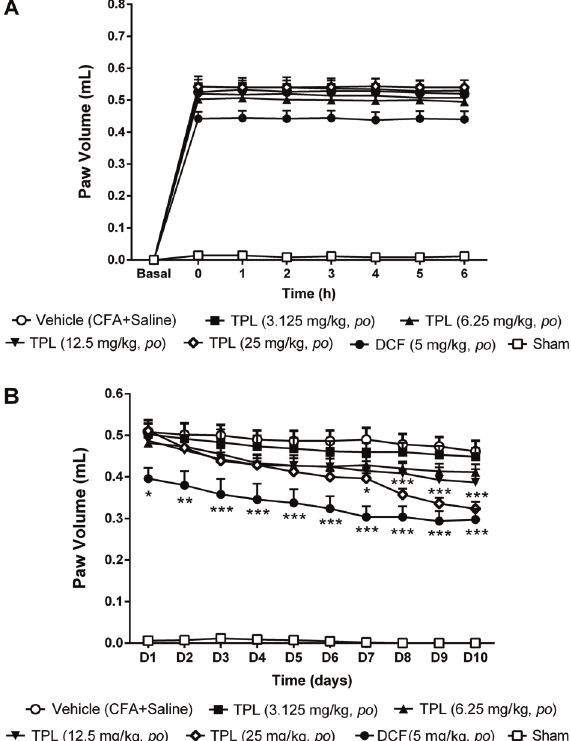
Figure 7 . Effect of acute ( A ) and chronic ( B ) administration of terpinolene monoterpene (TPL) on the paw edema induced by Freund ’ s complete adjuvant (CFA) in female rats (n=6 – 8). Each point represents the mean ± SEM of the paw volume (mL) before CFA injection (i.e., baseline) or at the times indicated thereafter. DCF: diclofenac. *P o 0.05, **P o 0.01 and ***P o 0.001 compared to vehicle group (two-way ANOVA, Bonferroni test).